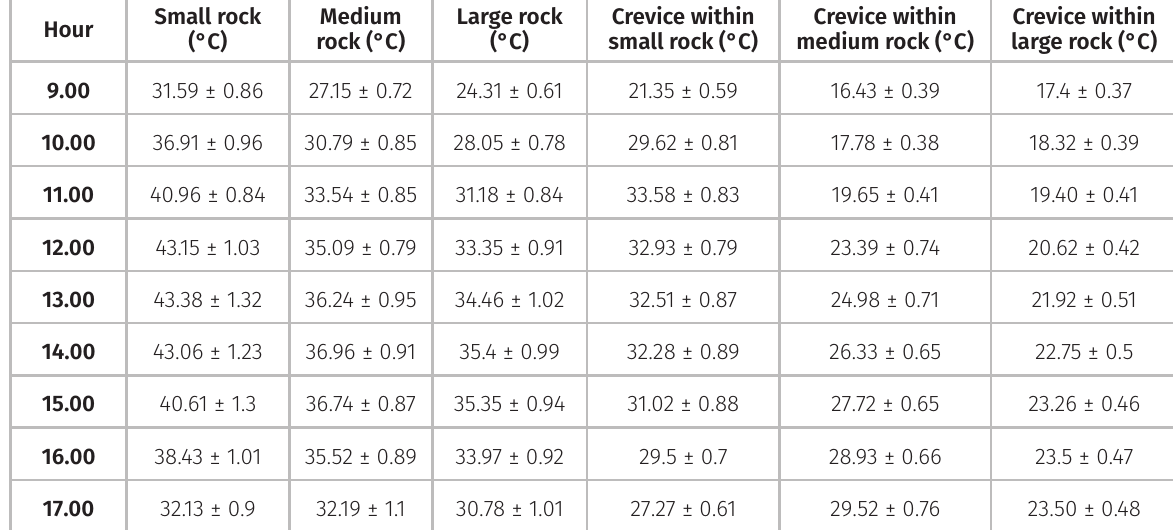
Table III. Operative temperature (Mean ± SE) of small, medium and large rocks and crevices within each of them per hour during activity period of Phymaturus